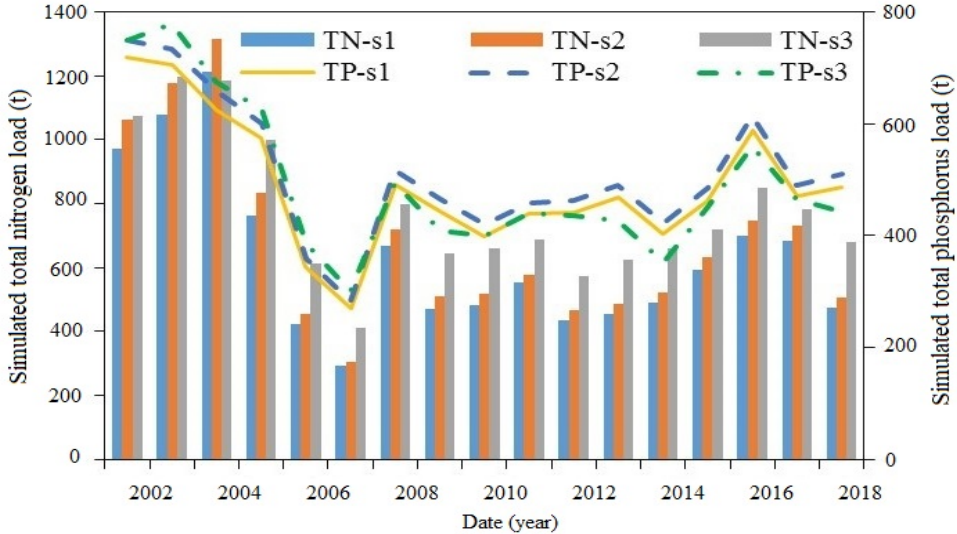
Figure 8. Interannual variation of the simulated total nitrogen and total phosphorus loads under the three land use scenarios.